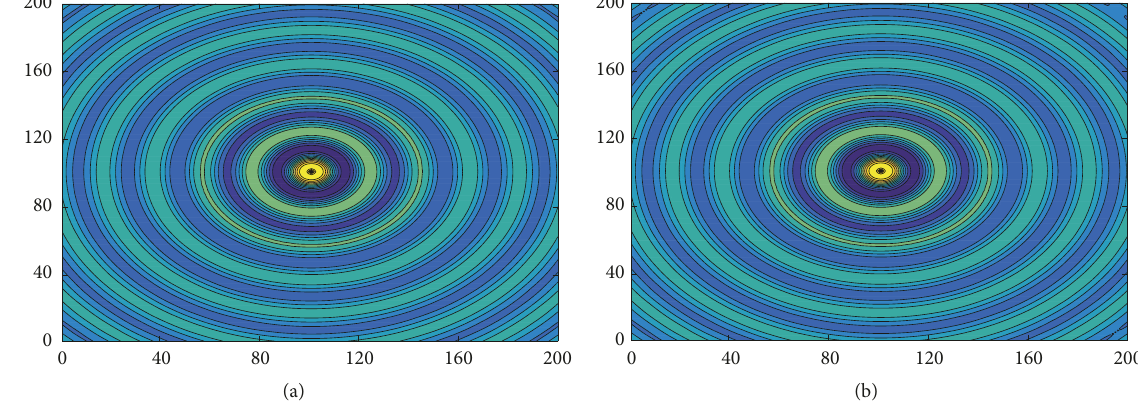
Figure 9: Variation diagram of the 𝐸 z field value. (a) Traditional FDTD method. (b) CUDA-implemented FDTD method.